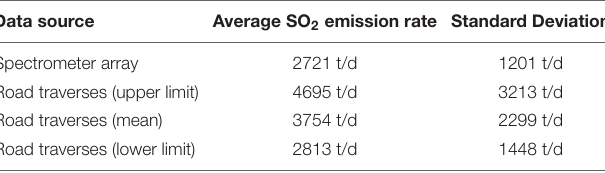
TABLE 3 | Summary of average emission rates obtained from the array and by DOAS vehicle traverses on Crater Rim Drive between 11:05 and 11:52 HST on